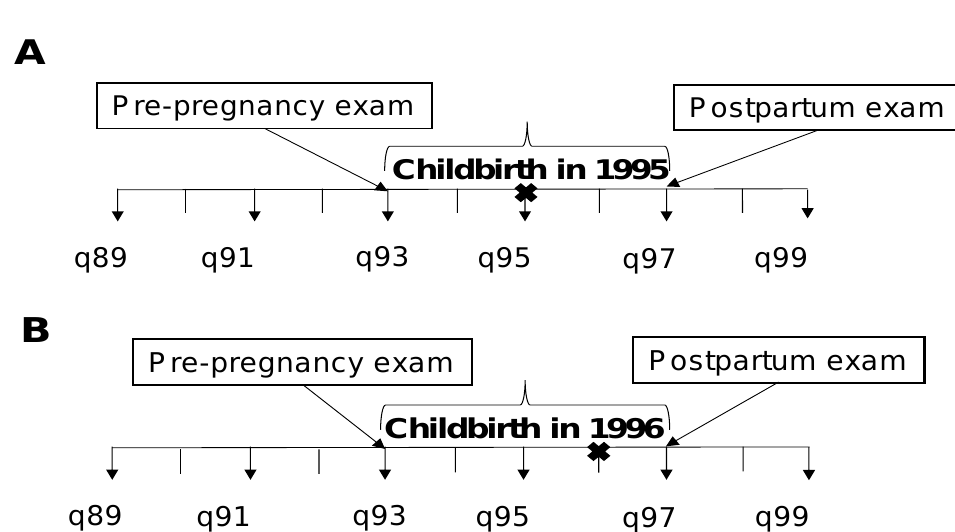
Figure 1. Study Timelines for Weight Retention Analyses. ( A ) represents the situation when childbirth happened in a year with questionnaire. ( B ) represents the situation when childbirth happened in a year without questionnaire. Q stands for questionnaire, and X indicates the timepoint of child- birth.